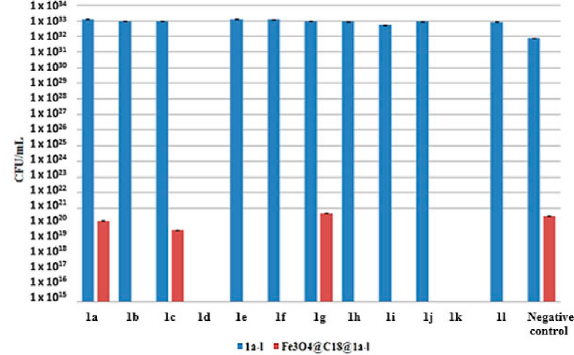
Figure 2. Viable cell counts of fungal cells harvested from 48 h biofilms developed on glass slides covered with bare compounds (C) (blue) or hybrid nanosystems (thiourea derivatives loaded at the same concentration in nanoparticles) (red).